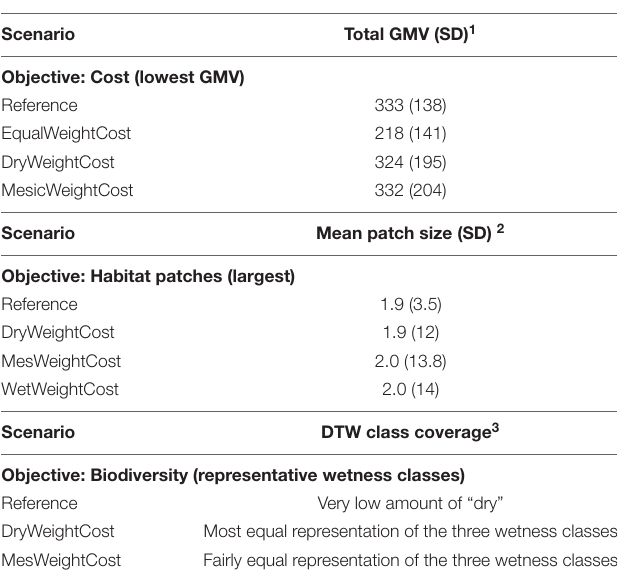
TABLE 7 | Assessment of the scenarios relative to three objectives: (i) lowest cost (lowest volume of merchantable timber left in retention); (ii) maintenance of habitat patches (largest retention patches); or iii) biodiversity (distribution of retention patches broadly representative of the range of